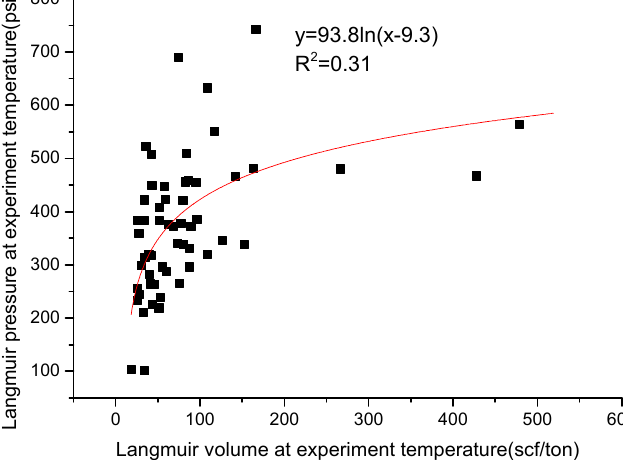
Figure 7. The relationship between the Langmuir pressure and Langmuir volume at experimental temperature for the studied samples.